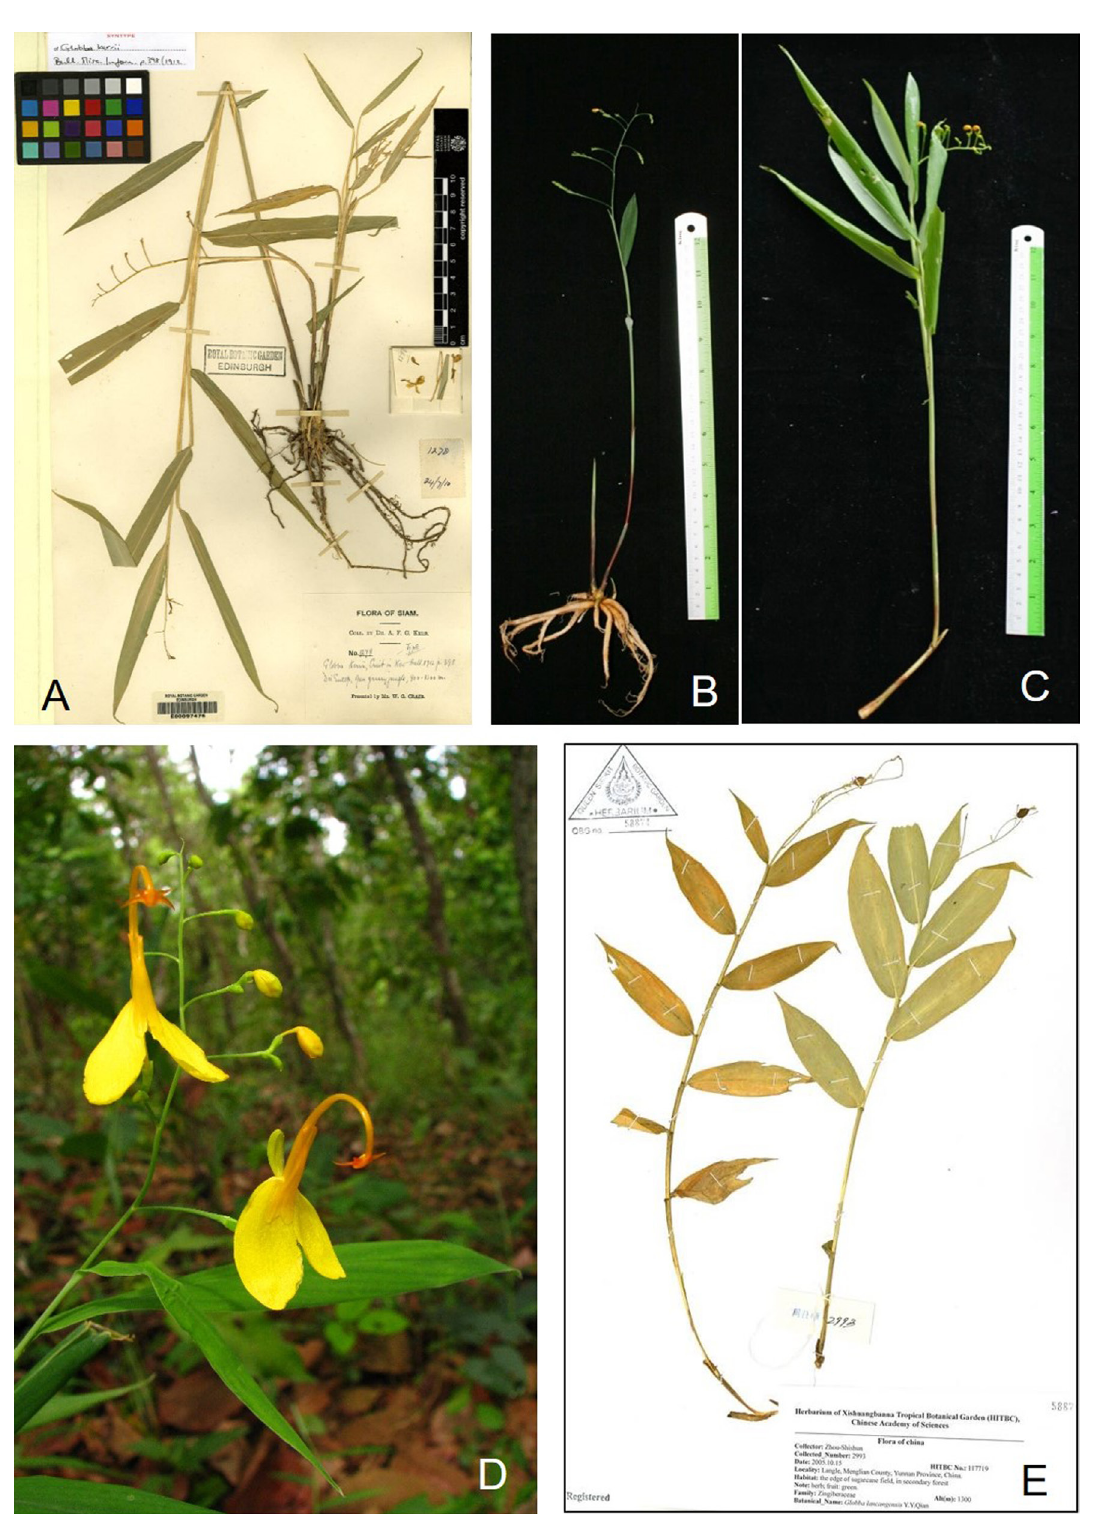
Fig. 9. A – C . G. insectifera Ridl. A . Isotype of G. kerrii Craib (E00097476). B . Inflorescence in dry season. C . Inflorescence in rainy season (S. Sangvirotjanapat 743 leg.). D – E . G. lancangensis Y.Y.Qian. D . Flowers (P. Suksathan s.n. leg.). E . Specimens from China, S.S. Zhou 2993 leg. (QBG). Photographs: A–C, E, S. Sangvirotjanapat; D, P.